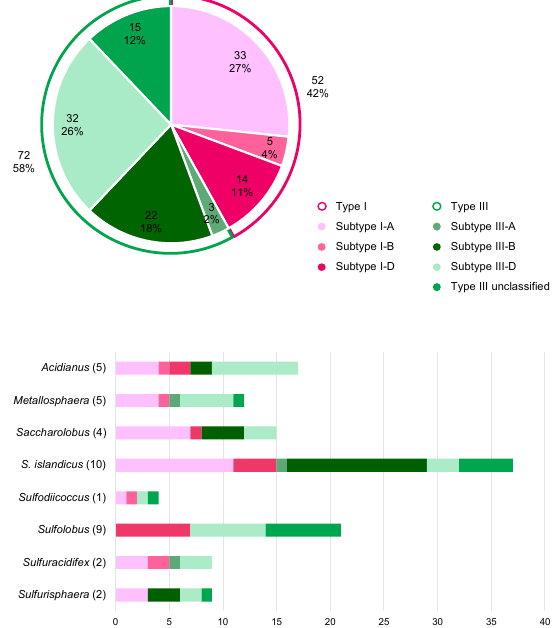
Figure 3. Presence of specific CRISPR-Cas (sub)types and their abundances among Sulfolobales genera. Overall abundances of CRISPR-Cas types and the specific subtypes within the general types I and III found in the order Sulfolobales (Upper panel). The bar chart shows the distribution of the CRISPR-Cas subtypes throughout the genera within Sulfolobales (Lower panel). The number of genomes included in the analysis for each genus is given in brackets. The analysis is based on data published in ref. [19] and/or obtained by using programs CRISPRminer (version 1, [258]), and CRISPRCasFinder (version CRISPR-Cas++ 1.1.2, [241]).